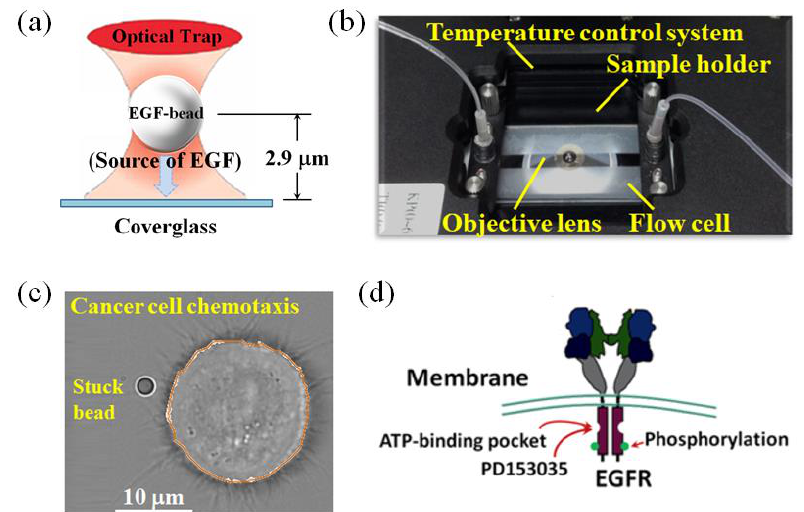
Figure 1. Schematic representation of the high-resolution optical tweezers applied to conduct spatial and temporal regulation of cell locomotion to simulate the chemosensing process mediated by EGF/EGFR signaling. ( a ) The trapped bead positioned close to the filopodia is stuck onto the cover glass surface via optical tweezers. ( b ) A single-cell detection platform, including temperature control system and flow delivery system, is integrated into an inverted fluorescence microscope. ( c ) A typical bright-field image of individual cellular responses during stuck-EGF-bead stimulation, where the stuck EGF-coated bead is intended to contact the filopodial actin filament of the HT29 cell. The corresponding 2D cell body contour is also shown, highlighted with an orange line. ( d ) A schematic representation of PD153035 binding to the active ATP catalytic site of the intracellular domain of EGFR.